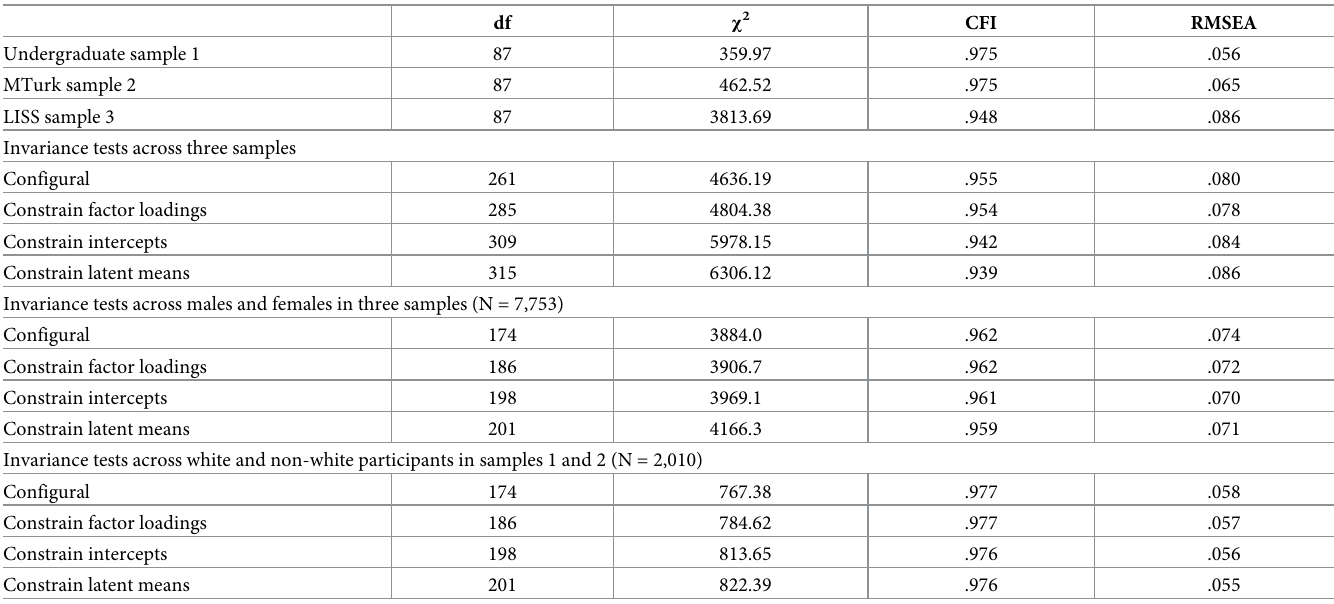
Table 2. CFA model fit for the VEMI in three samples.